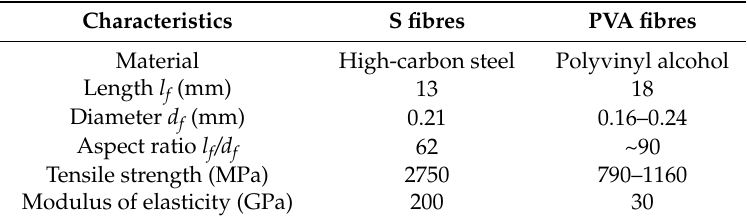
Table 6. Geometrical and mechanical properties of the short fibres (high-carbon steel S and polyvinyl alcohol